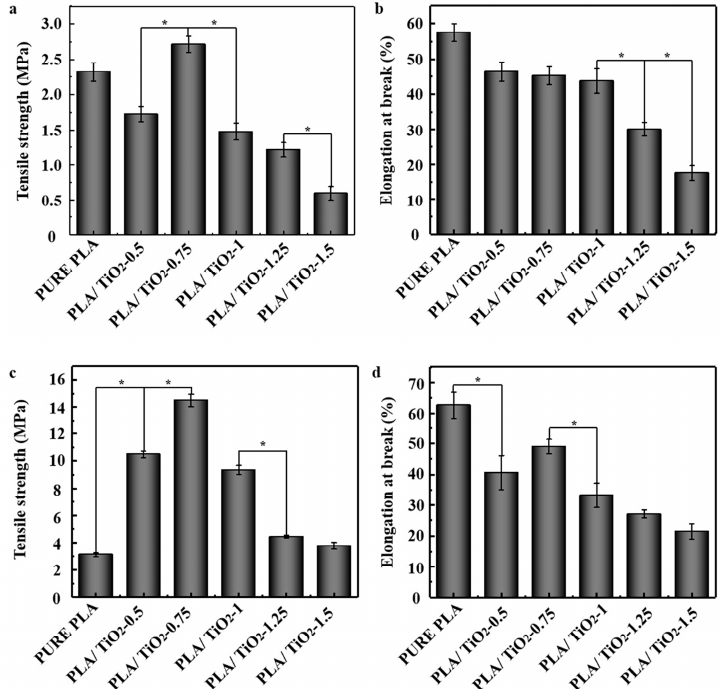
Figure 7. Variation in tensile strength (TS) and elongation at break (EB) of PLA nanofibers and films: ( a , b ) nanofibers; ( c , d ) films. Columns with * mean significantly different ( P ≤ 0.05).